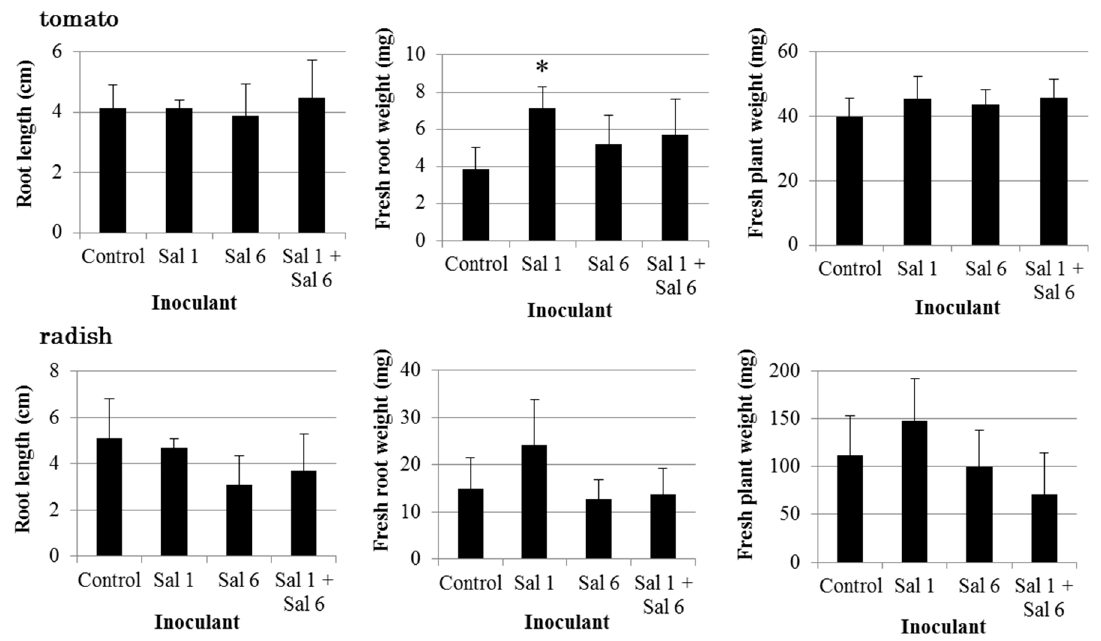
Figure 4. Effect of inoculation of IAA-producing (Sal 1) and -degrading (Sal 6) strains on the growth of tomato and radish plants. The bars represent the standard deviation (n = 7–12). Asterisk indicates a significant difference at P < 0.001 using Tukey’s test.